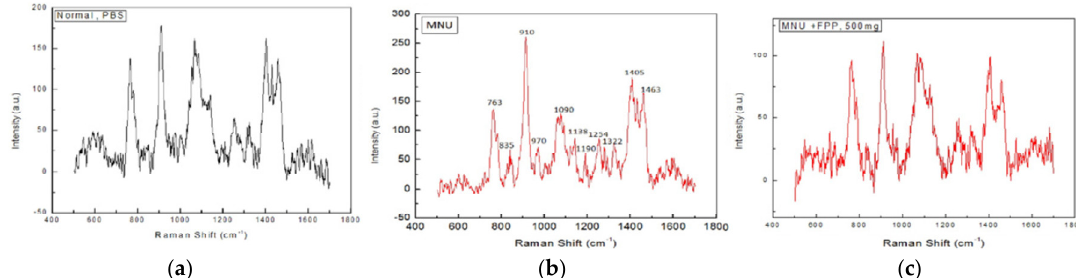
Figure 5. Comparison of Raman laser spectra of liver DNA in the region of 400–1700 cm − 1 for all experimental groups: ( a ) PBS control, ( b ) MNU control, ( c ) MNU + 500 mg FPP/kg BW. Data is representative of eight replicates. [Parameters: resolution cm − 1 , step of 100 nm, laser power 5 mW, exciting source 514.5 nm argon ion laser]. Reproduced with permission from Somanah et al. [71], Life Sciences; published by Elsevier, 2016.